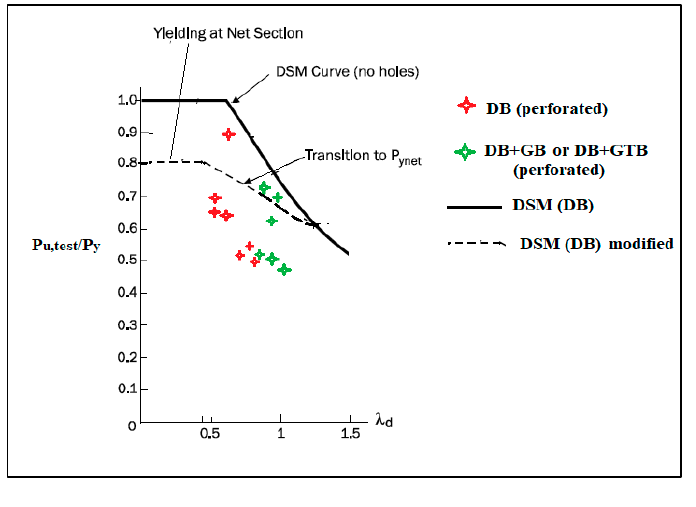
Figure 8. Comparison between the modified DSM distortional strength curve and experimental test results.